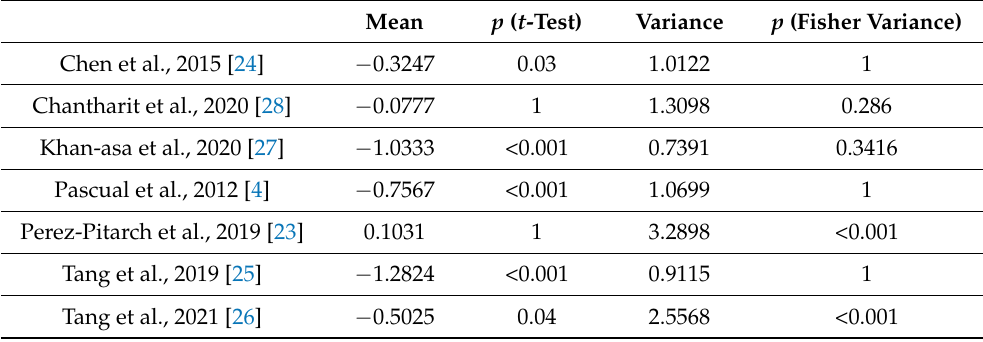
Figure 1. Goodness-of-fit plots for the investigated population PK models comparing population predictions with the second measured plasma concentration [4,23–28]. Black line: line of identity; blue line: linear regression line. Points: measured concentrations. Table 2. Mean and variance of the NDPE distribution.